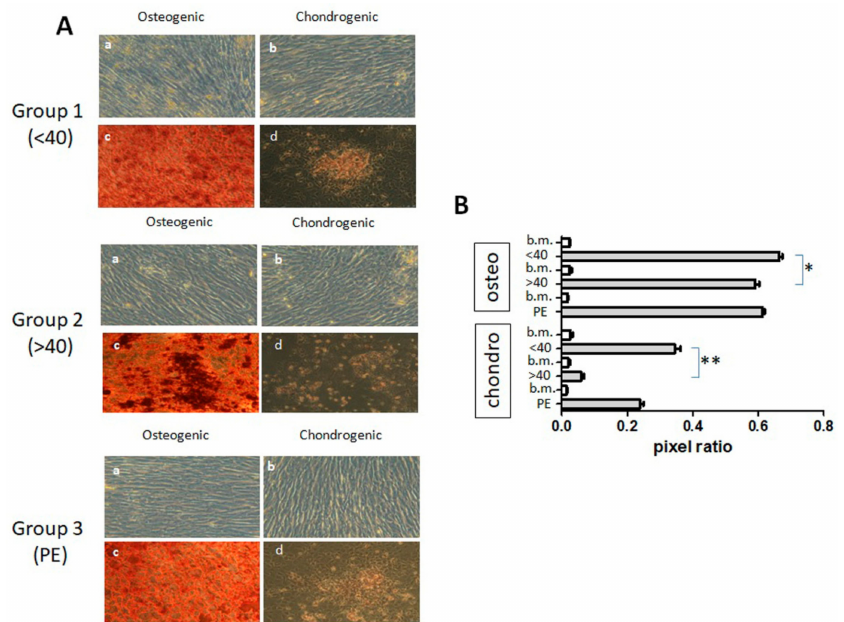
Figure 4. Di ff erentiation of hAMSCs obtained from Group 1, Group 2, and Group 3. Panel ( A ) shows p2 cells that were induced either in basal medium (a, b) or in di ff erentiation medium of osteogenesis (c) or chondrogenesis (d). Representative panels of three di ff erent hAMSC isolates for each Group are shown. Magnification: 10 × . Panel ( B ) illustrates the pixel ratio of hAMSCs of the three donors for each Group grown in di ff erent conditions. b.m. stands for basal medium (conditions a and b in Panel A). * P < 0.05; ** P <